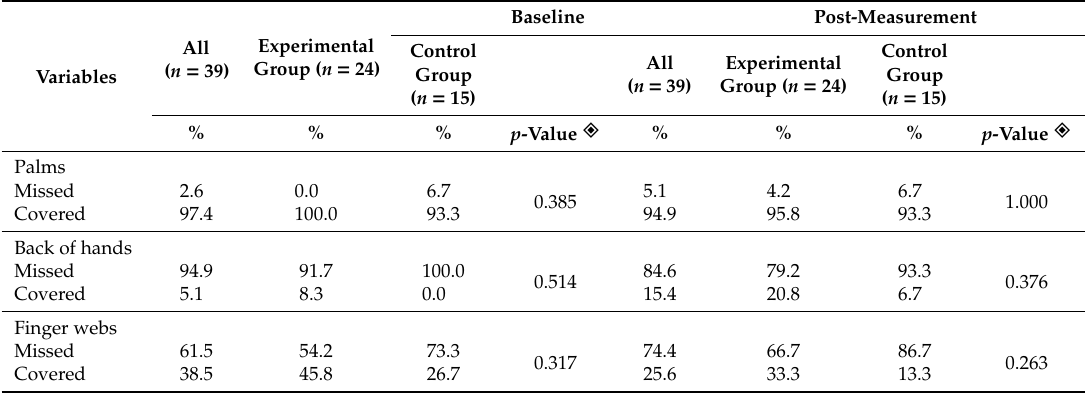
Table 3. Regions of hands covered by hand sanitizer.